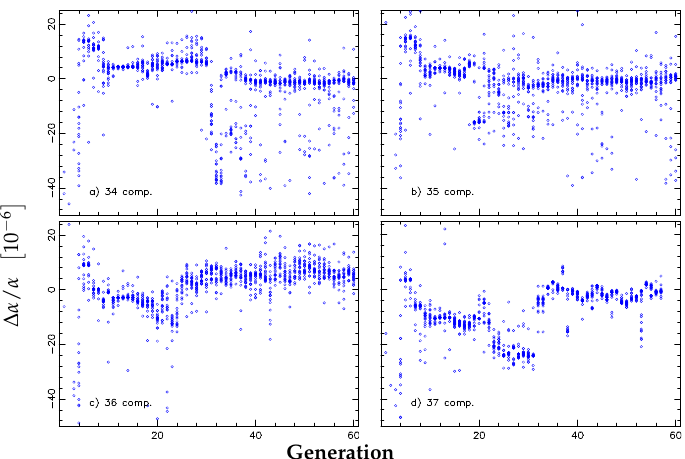
Figure 4. ∆ α / α vs generation for the four synthetic spectra with the most complex velocity structures in our sample. The underlying (real) ∆ α / α is set to zero in all cases. Each panel shows the ∆ α / α estimates of the models generated during the analysis of each synthetic spectra. The underlying (real) model used to generate the synthetic spectra have 34, 35, 36 and 37 velocity components for Panels (a), (b), (c) and (d) respectively. At increasing generation number, the models become increasingly complex (as greater numbers of velocity components are identified by GVPFIT).